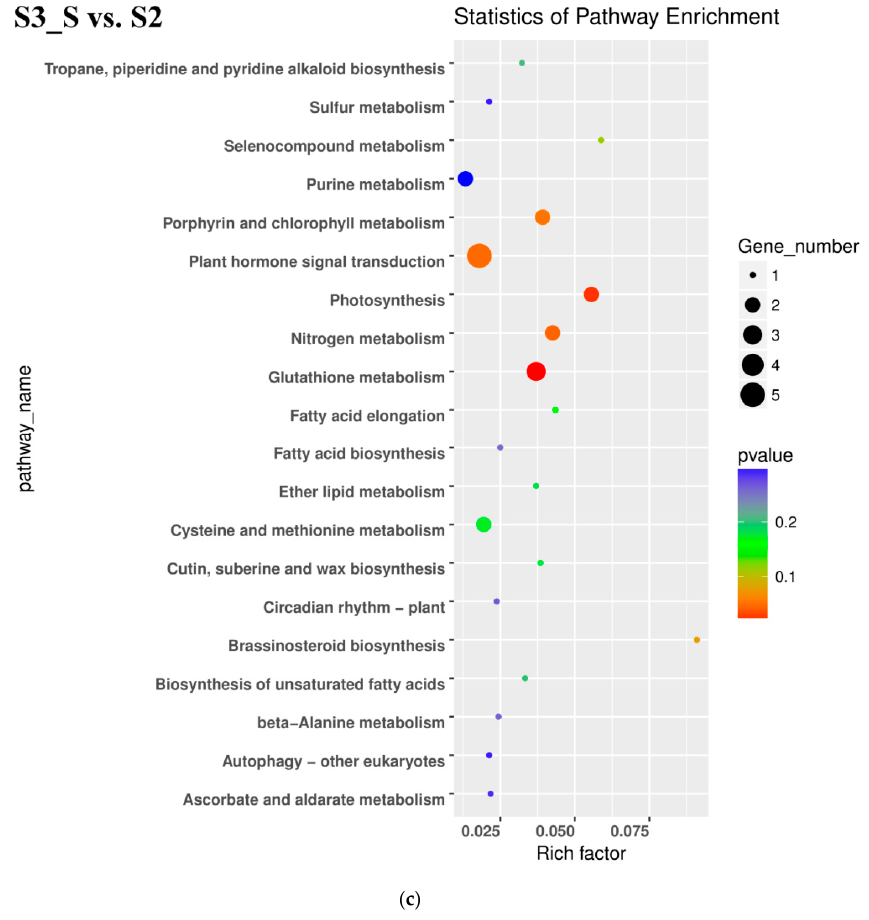
Figure 6. Kyoto Encyclopedia of Genes and Genomes (KEGG) enrichment analysis in pairwise comparisons. ( a ) KEGG enrichment analysis in S2 vs. S1. ( b ) KEGG enrichment analysis in S3_S vs. S3_C. ( c ) KEGG enrichment analysis in S3_S vs. S2.